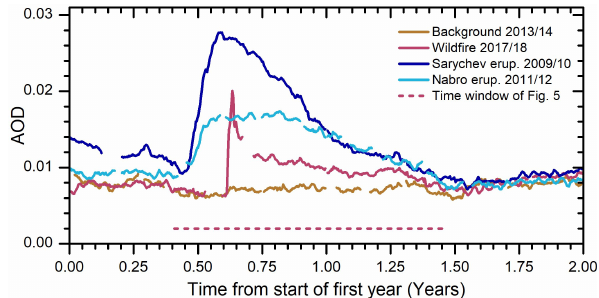
Figure 9. Evolution of the AOD in the 20–80 ◦ N interval (8d mov- ing average) over 2 years; close to background conditions in the latitude interval studied (2013–2014), the year and the following year of the 12 August 2017 fire (2017–2018), and the same for two volcanic eruptions, the 12 June 2009 Sarychev (2009–2010) and 12 June 2011 Nabro (2011–2012)